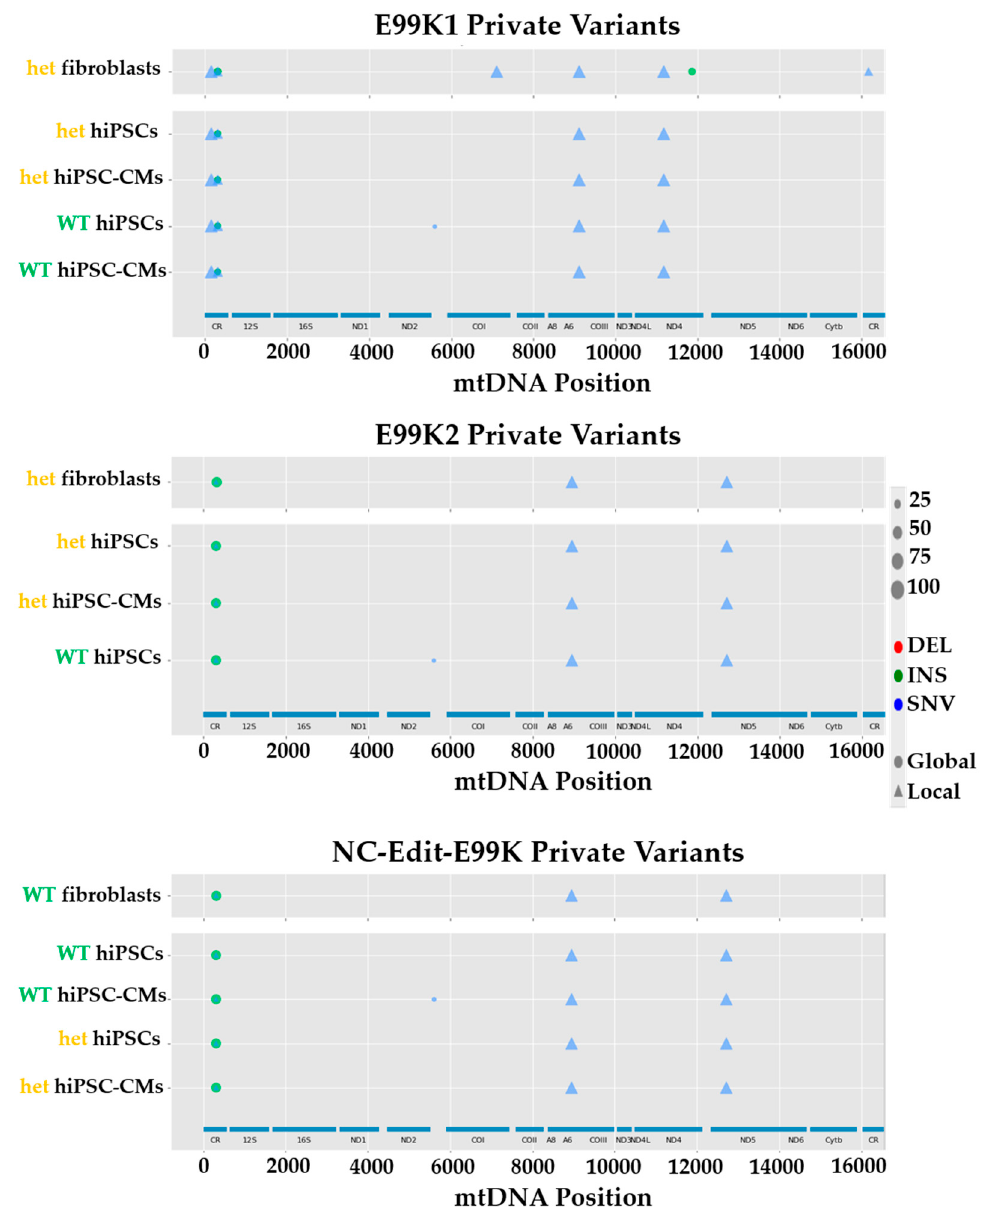
Figure 3. mtDNA NGS of three separate isogenic sets bearing the p.E99K-ACTC1 mutation. Analysis of mtDNA sequence of isogenic sets of fibroblasts, hPSCs and hPSC-CMs of E99K1 (top), E99K2 (middle) and NC-Edit-E99K (bottom) identified variants specific to the starting cell sources. Legend map on the right side indicates type of mtDNA mutation (DEL, deletion; INS, insertion; SNV, single nucleotide variant) and percent heteroplasmy is correlated with the size of the symbol. (WT, wild-type; het, heterozygous). Table 2. mtDNA variants identified by NGS in p.E99K-ACTC1 isogenic lines used for HCM modeling (WT, healthy; het, heterozygous). In silico pathogenicity prediction algorithms used: § MitoTIP; * Polyphen-2; † CAROL; ‡ APOGEE. Phenotypically severe hPSC-CM line is highlighted in red and less severe ones in green.